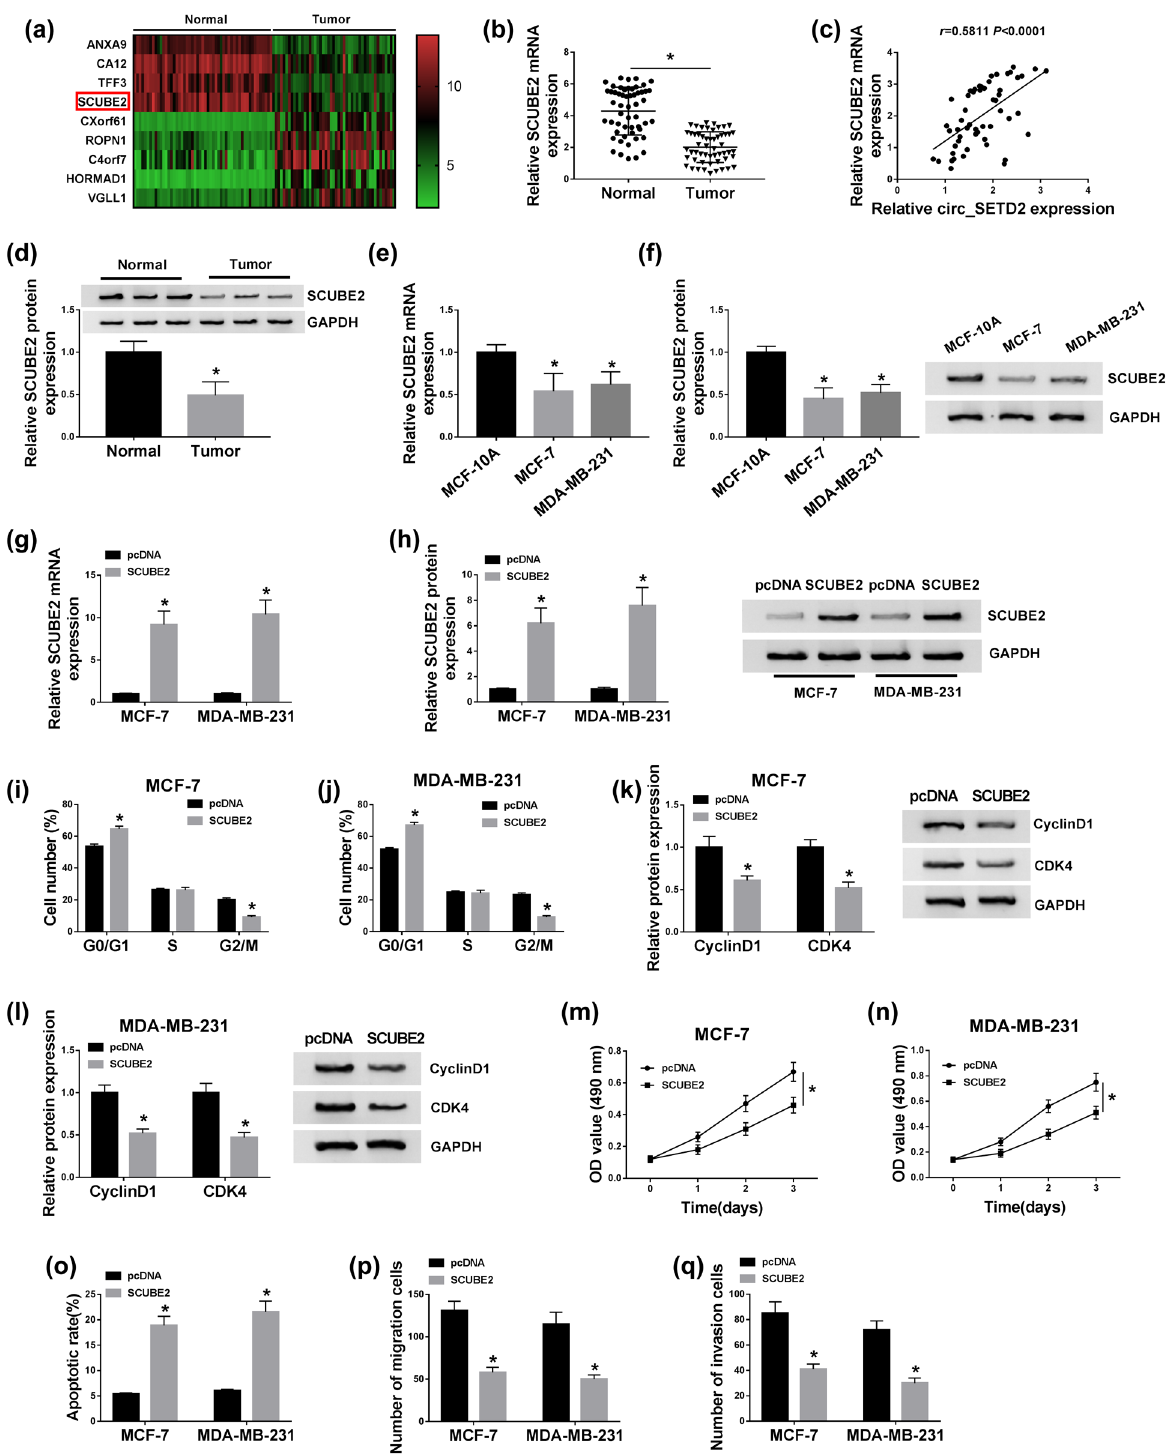
Figure 3: In fl uence of SCUBE2 introduction on cell cycle progression, proliferation, apoptosis, migration, and invasion of BC cells. ( a ) The expressionofSCUBE2inBCtissuescomparedwithnormaltissueswasassessedthroughusingtheGEOdatasetGSE62931. ( b ) ThemRNAlevel ofSCUBE2inBCtissuesandadjacentnormaltissueswasexaminedwithqRT - PCR. ( c ) Pearson ’ scorrelationanalysiswasusedtoevaluatethe correlation between SCUBE2 and circ_SETD2 in BC tissues. ( d ) Expression of SCUBE2 protein in BC tissues and adjacent normal tissues was detected by western blot analysis. ( e – h ) The mRNA and protein levels of SCUBE2 in MCF - 7 and MDA - MB - 231 cells, as well as MCF - 7 and MDA - MB - 231cellstransfectedwithSCUBE2orpcDNAwereassessedbyqRT - PCRorwesternblotanalysis. ( iandj ) Thee ff